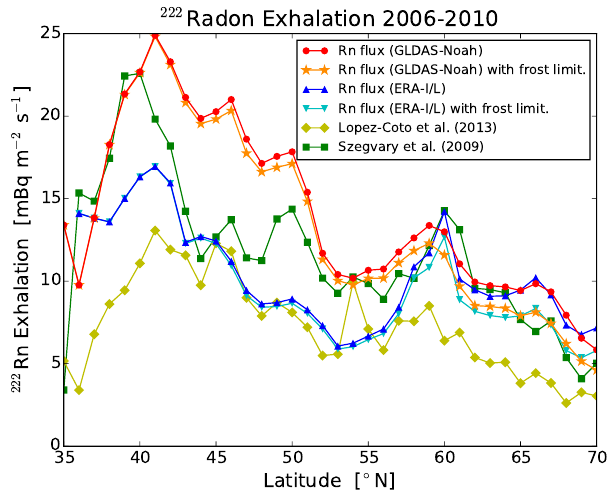
Figure 5. Latitudinal gradient of annual mean 222 Rn exhalation rates for 2006–2010 from this study in comparison with published maps (Szegvary et al., 2009; López-Coto et al., 2013). Zonal aver- age land surface fluxes for 1 ◦ latitude bands are shown.